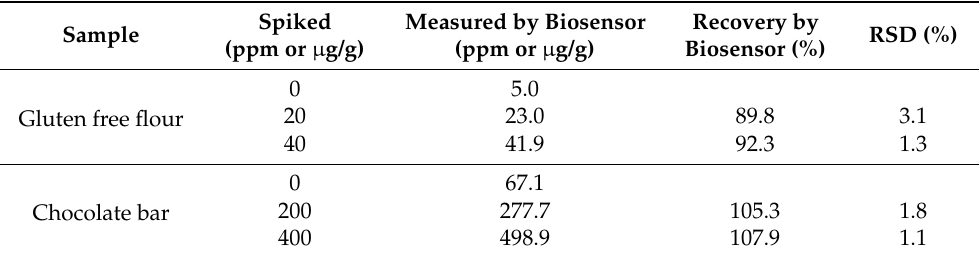
Table 2. Determination of gluten/Ara h 1 in spiked